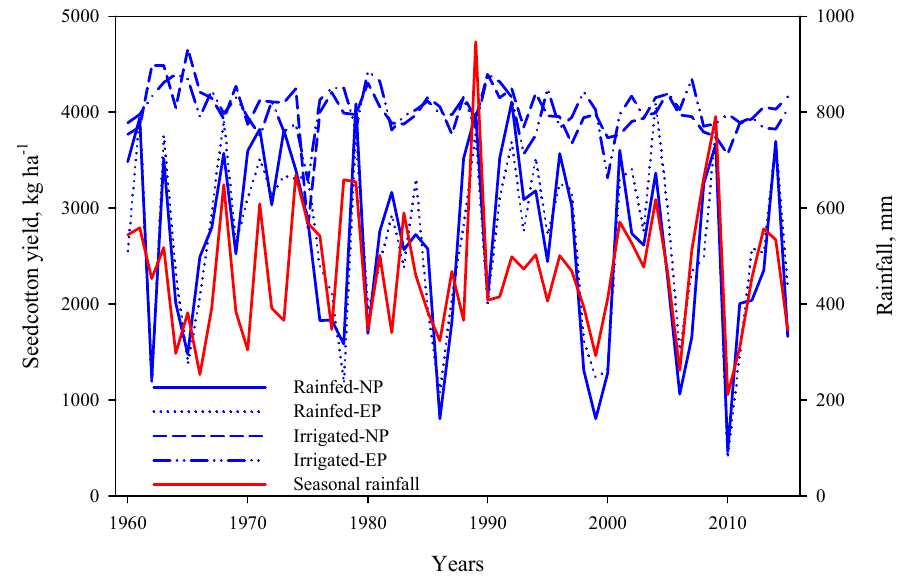
Figure 5. Simulated seed cotton yields of normal (NP) and early plantings (EP) under rainfed and